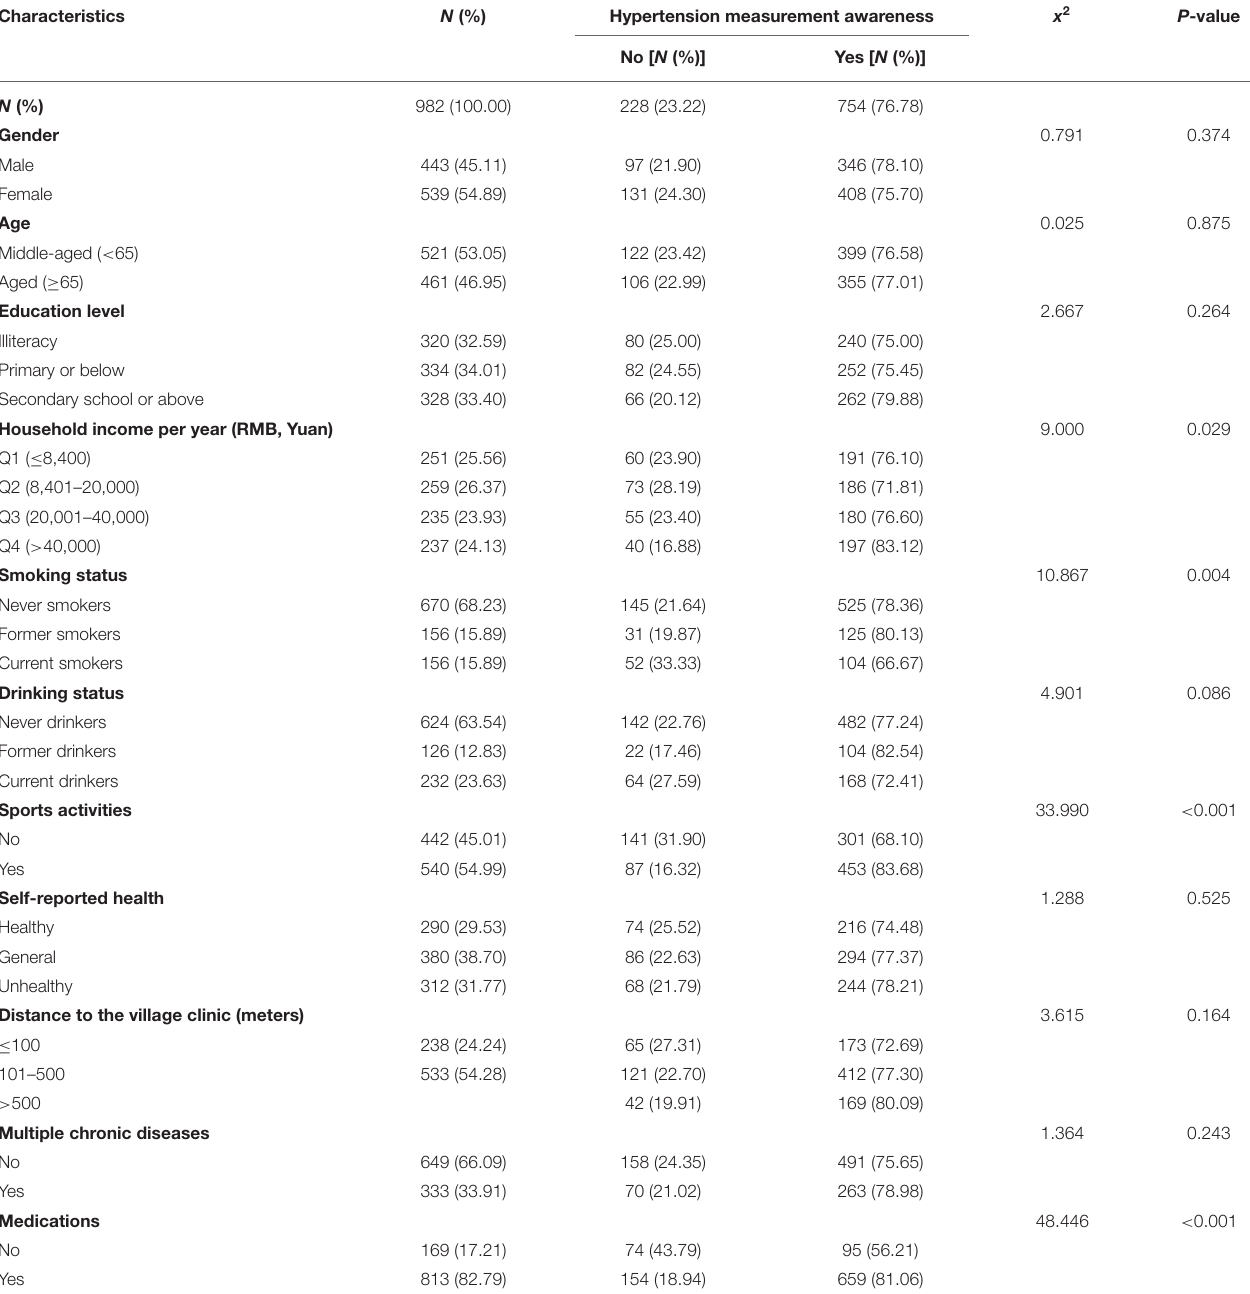
TABLE 1 | Description and signal analysis of blood pressure measurement awareness among hypertension patients in rural Shandong, China ( N = 982).